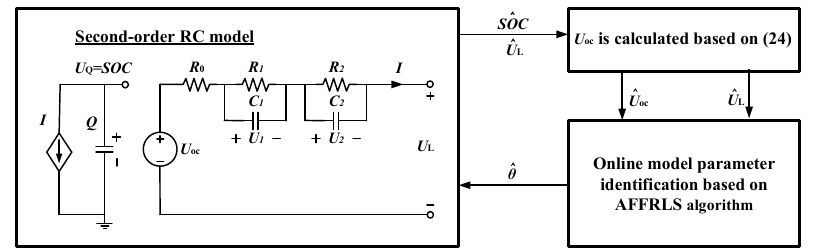
Figure 2. Overall block diagram of the online identification parameters.